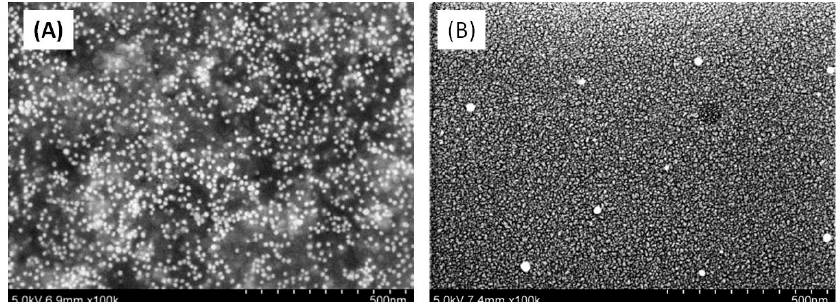
Figure 9. SEM images of ( A ) deposited 10 nm NPs after ablation, and ( B ) deposited NPs synthesized during ablation of Au bulk target by 200 ps pulses.